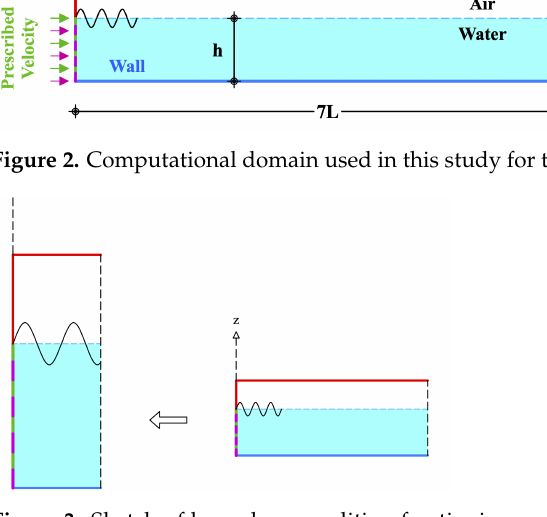
Figure 3. Sketch of boundary condition fractioning region used in the wave generation with the proposed